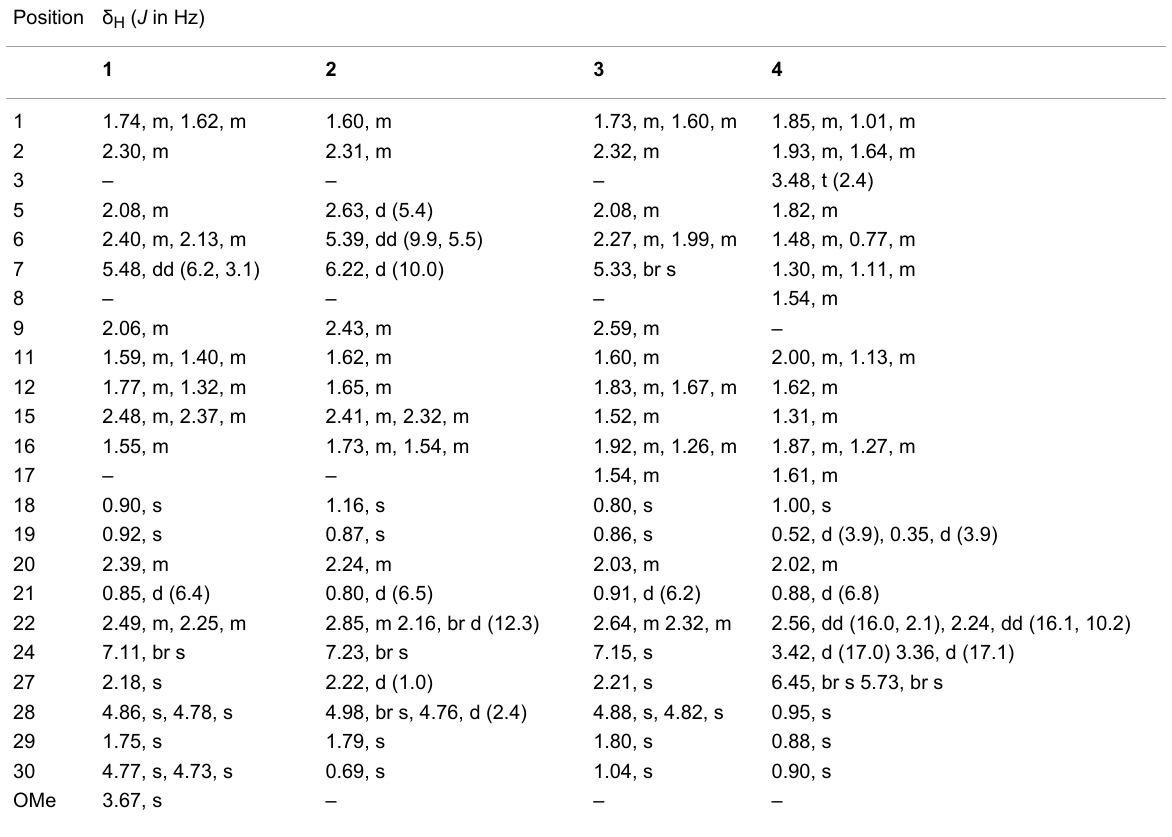
Table 2: 1 H NMR spectroscopic data (400 MHz, CDCl 3 ) of compounds 1 – 4 . Position δ H ( J in Hz)